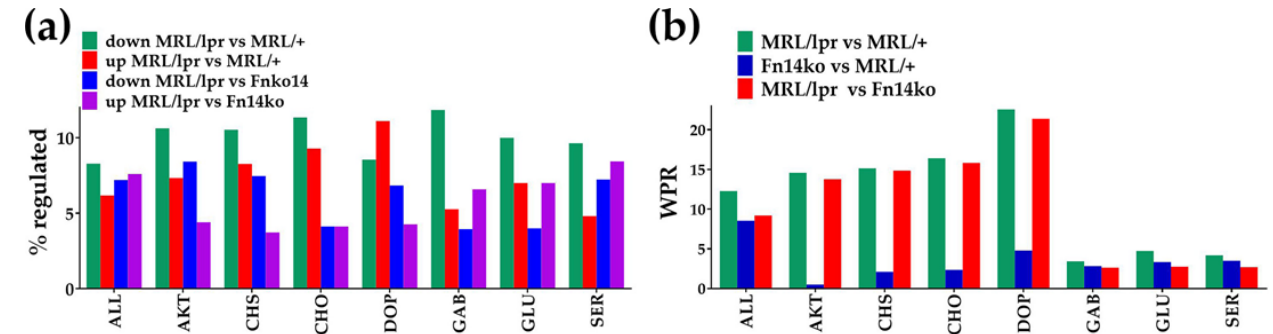
Figure 3. Overall transcriptomic differences in the analyzed pathways among the three phenotypes. ( a ) Percentages of up- and down-regulated genes in selected pathways for indicated comparisons. ( b ) Weighted Pathway Regulation (WPR) of selected pathways. AKT, PI3K-AKT pathway; CHS, chemokine signaling pathway; CHO, cholinergic neurotransmission; DOP, dopaminergic neurotransmission; GAB, GABAergic neurotransmission, GLU, glutamatergic neurotransmission; SER, serotonergic neurotransmission.